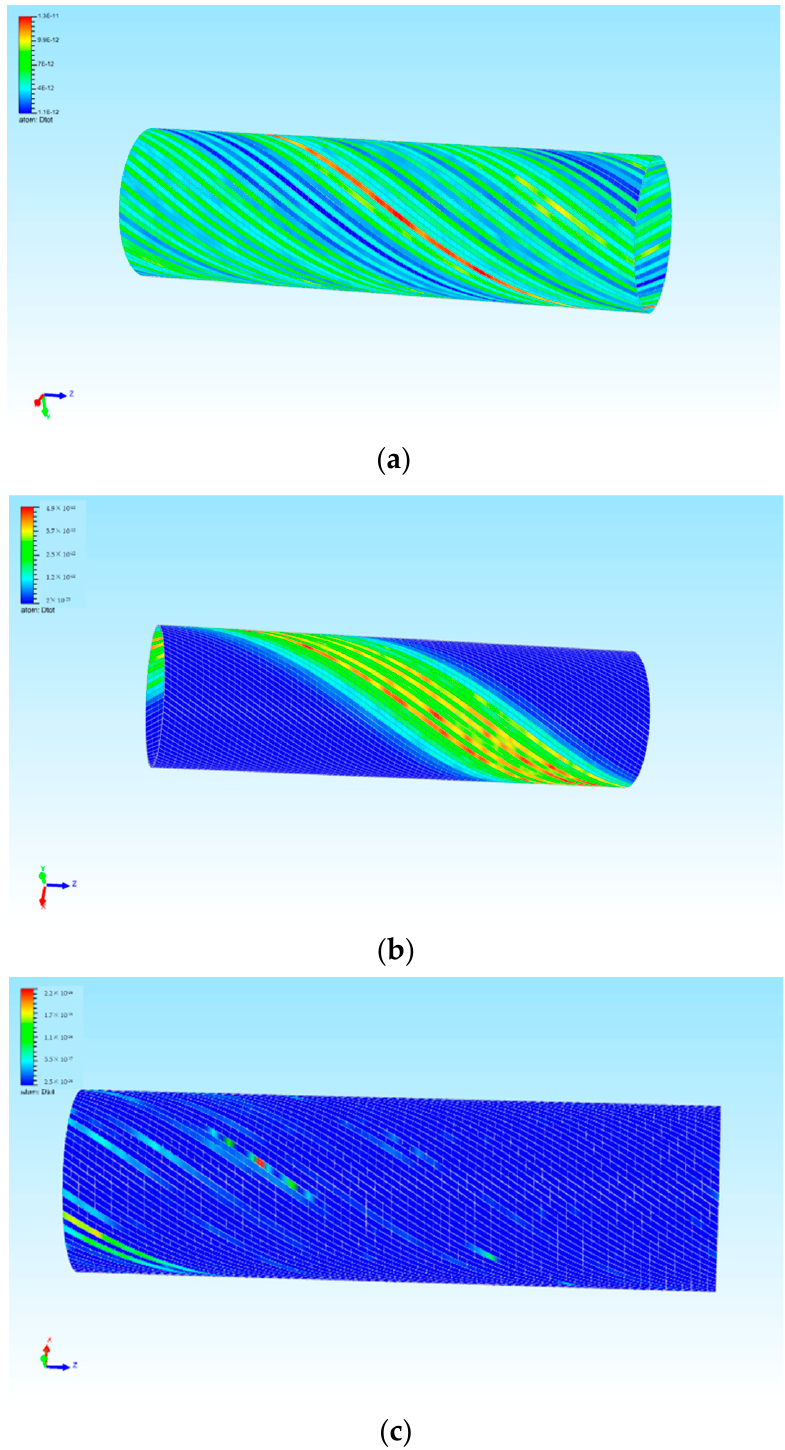
Figure 13. Fatigue damage of an internal tensile armor layer. ( a ) The fatigue damage nephogram under axial compressive load; ( b ) The fatigue damage nephogram under bending moment; ( c ) The fatigue damage nephogram under torsion.